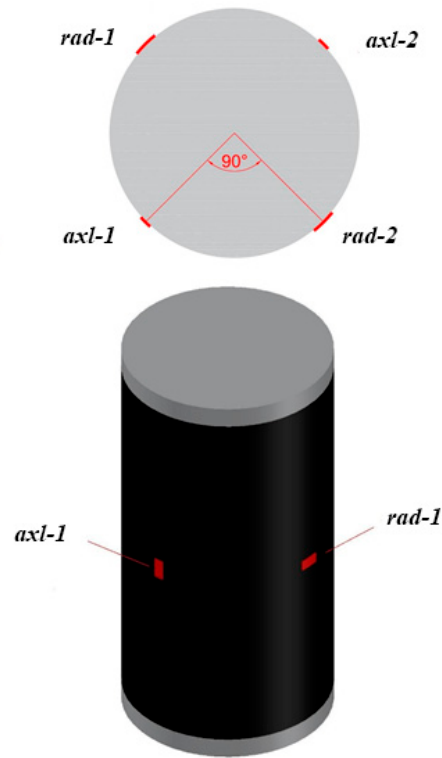
Figure 4. Pre-loaded series specimen preparation: matrix application (left); and CFRP-confinement (right). 3.3. Test Lay-Out and Specimen Preparation Table 2 shows the results of the axial compression tests in terms of average values representing the ultimate axial stress f ccu and strain ε ccu and lateral deformation ε lu . Figure 5 shows experimental curves in forms of ideal bilinear trends. This is useful to distinguish the different behaviors before and after the full activation of FRP-confinement. Figure 6 reports the failure modes observed for all the tested FRP-confined specimens. In all cases, the final stage was accompanied by the tensile rupture of the carbon fibers in one or more regions along the height of the cylinders. The sample named P0_3 showed extreme